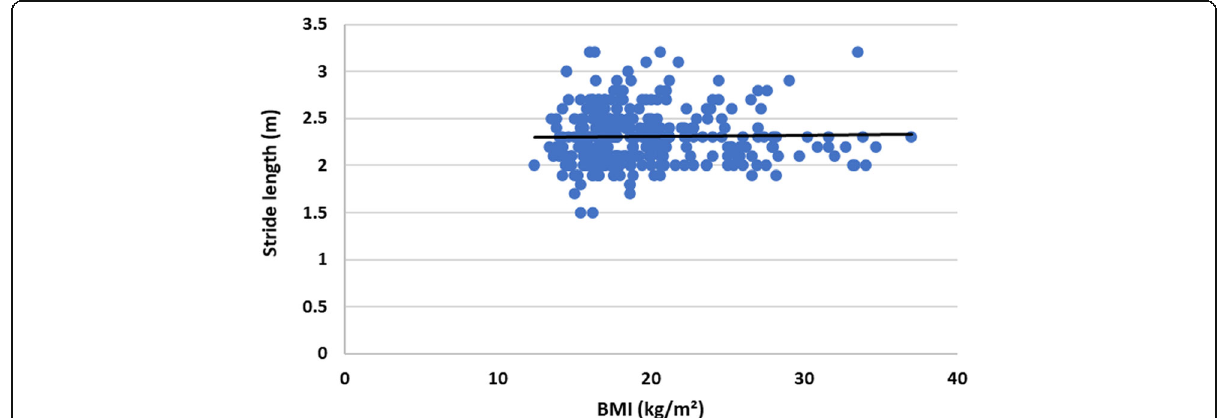
Fig. 2 Correlation between BMI and stride length of the